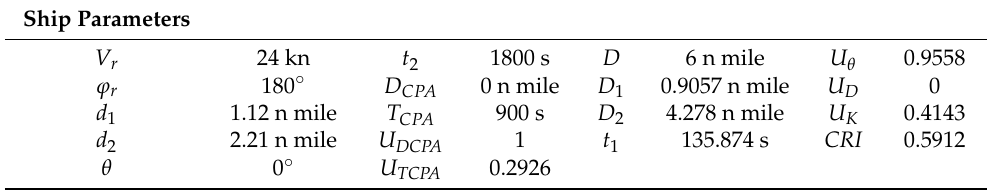
Table 1. Related parameter variables.